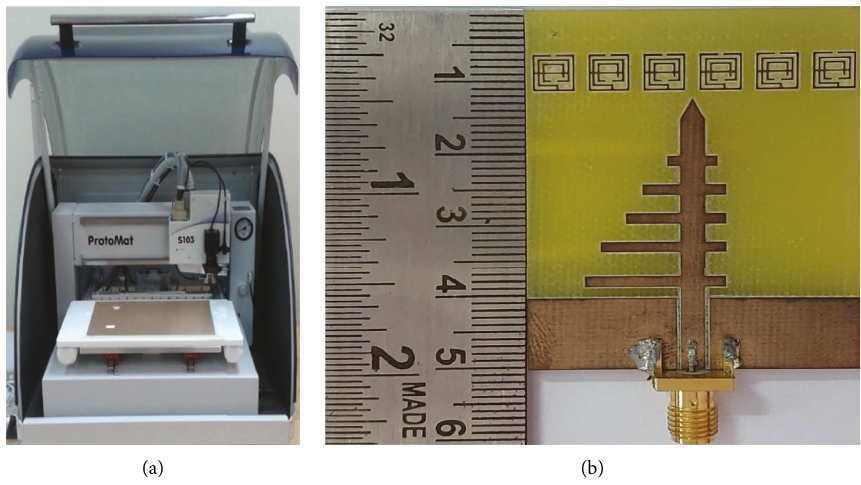
Figure 9: (a) The LPKF (S103) protoMat machine and (b) The PLPA antenna prototype.